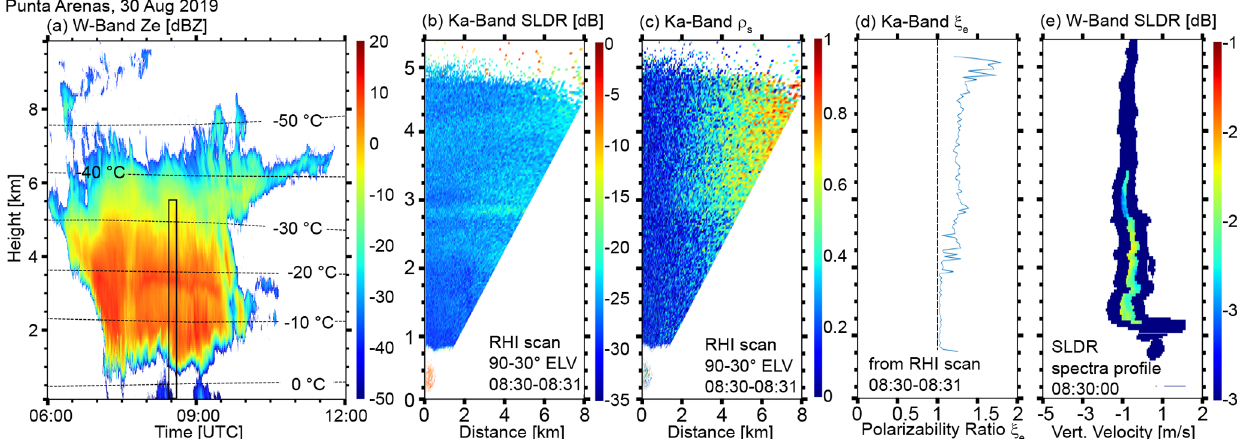
Figure 4. Case study of a deep mixed-phase cloud event observed with multiwavelength polarimetric cloud radars at Punta Arenas, Chile, on 30 August 2019. (a) Vertical-pointing W-band (94GHz) radar reflectivity factor Z e and isolines of modelled air temperature. (b) (c) Ka- band (35GHz) RHI scans (90–30 ◦ elevation) of slanted linear depolarization ratio (SLDR) and co-cross-correlation coefficient in the slanted basis ρ s , respectively, from 08:30–08:31UTC. (d) Profile of the shape index polarizability ratio ( ξ e ) obtained from the RHI scans shown in (b) and (c) and (e) height spectrogram (at 90 ◦ elevation) of W-band SLDR from 08:30:00UTC. The time and height frame of (b–e) is indicated by the black rectangle in (a)